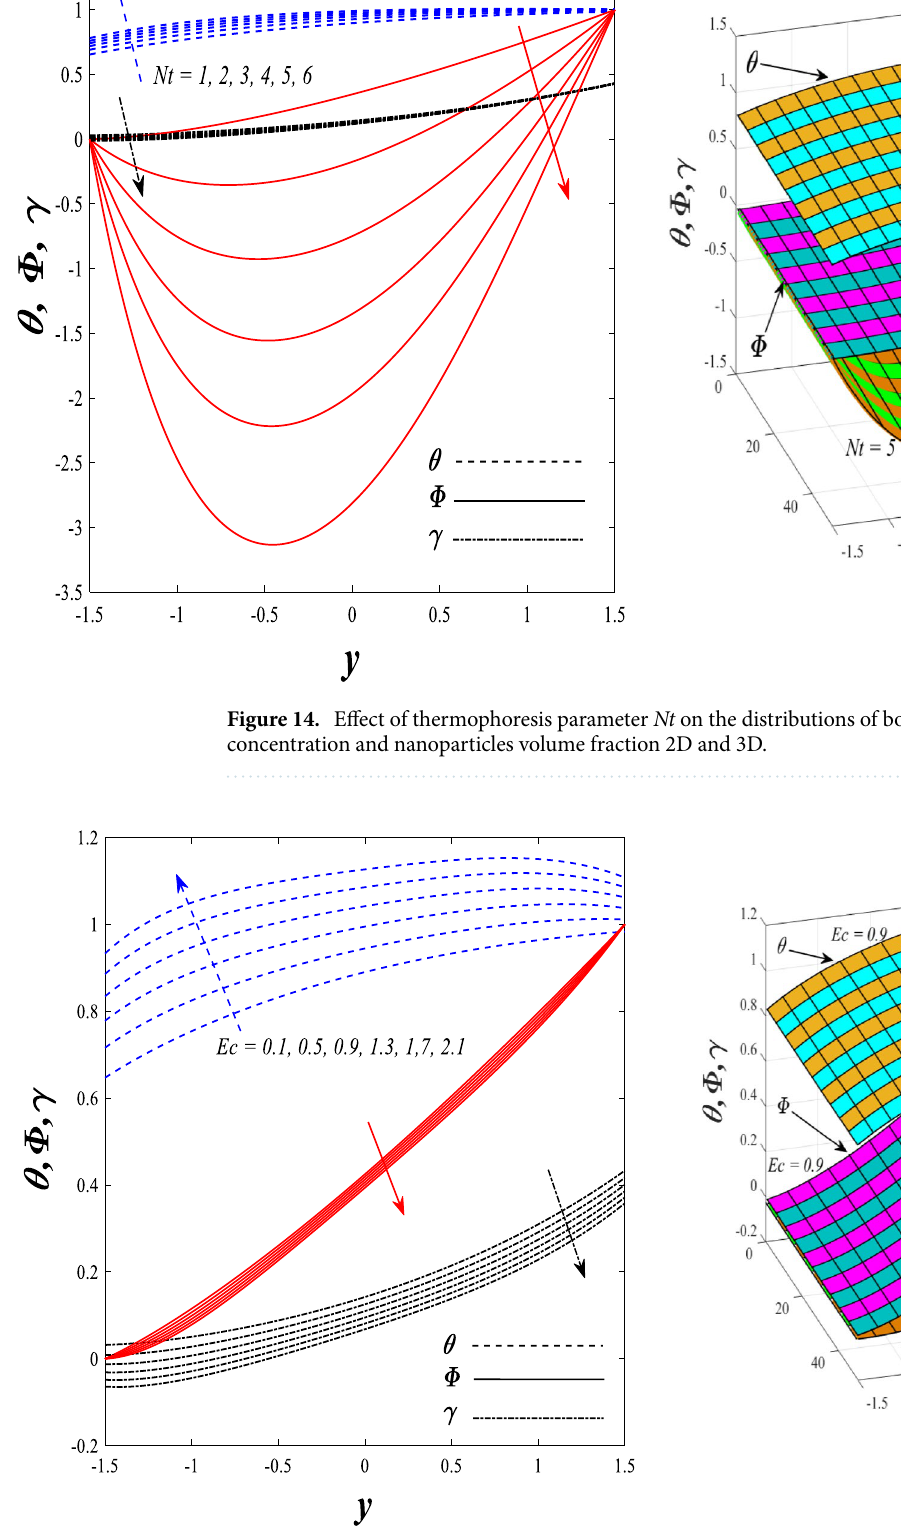
Figure 15. Effect of Eckert number Ec on the distributions of both temperature, solutal concentration and nanoparticles volume fraction 2D and